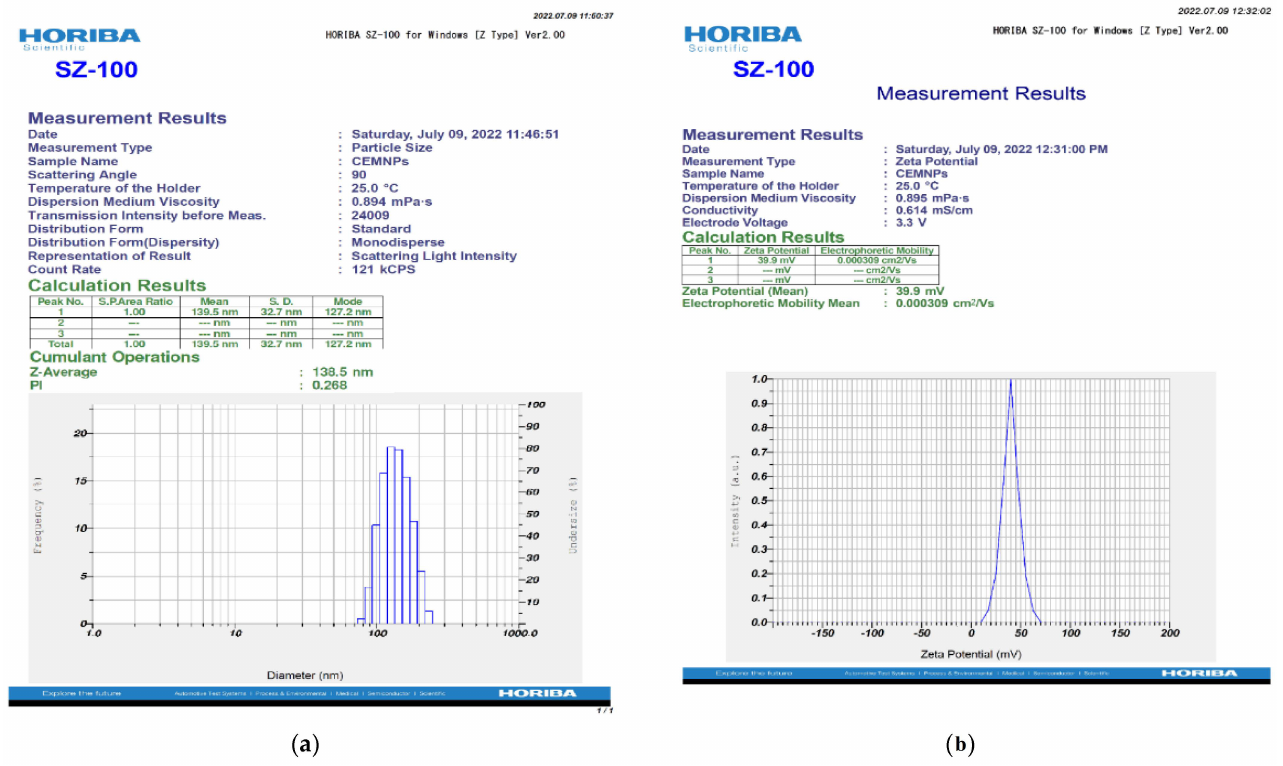
Figure 3. Hydrodynamic diameter ( a ) and zeta potential ( b ) of chitosan-encapsulated meloxicam nanoparticles (CEMNPs) in carboxymethyl cellulose (CMC; 0.1% w / v